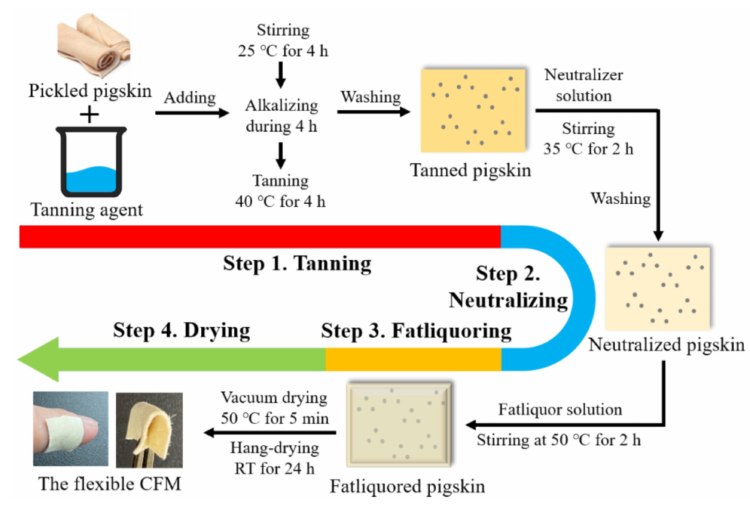
Figure 2. Preparation process of the pigskin